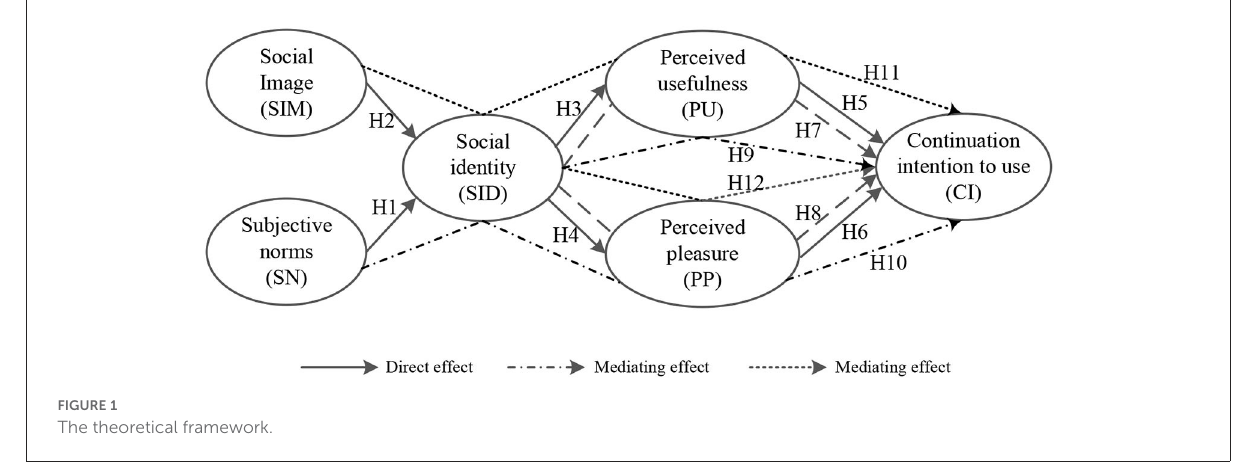
FIGURE1 The theoretical framework.